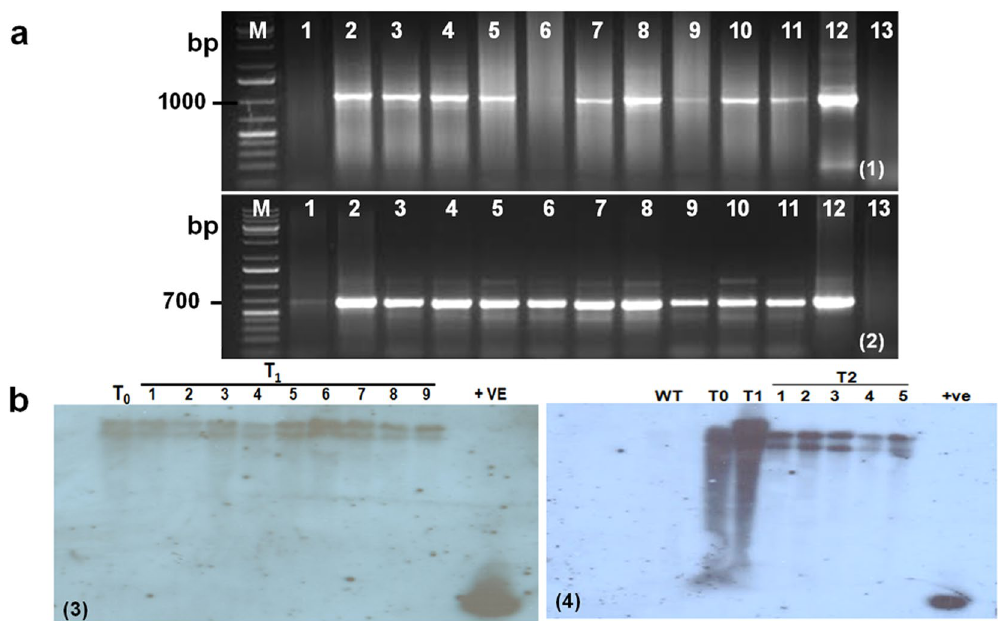
Figure 3. Molecular analysis of Transgenic TP-309 plants. ( a ) PCR analysis of putative transgenic plants using RPMK (1) and hpt II (2) gene specific primers. In both figures lane #12 is + ve control and lane #13 is − ve control; ( b ) Southern blot analysis showing the integration of the transgene in the T 1 (3) and the T 2 generation (4) of RP1 line. Original images of gel and Southern blots are also presented in supplementary information as Supplementary Fig. S2 and Supplementary Fig.